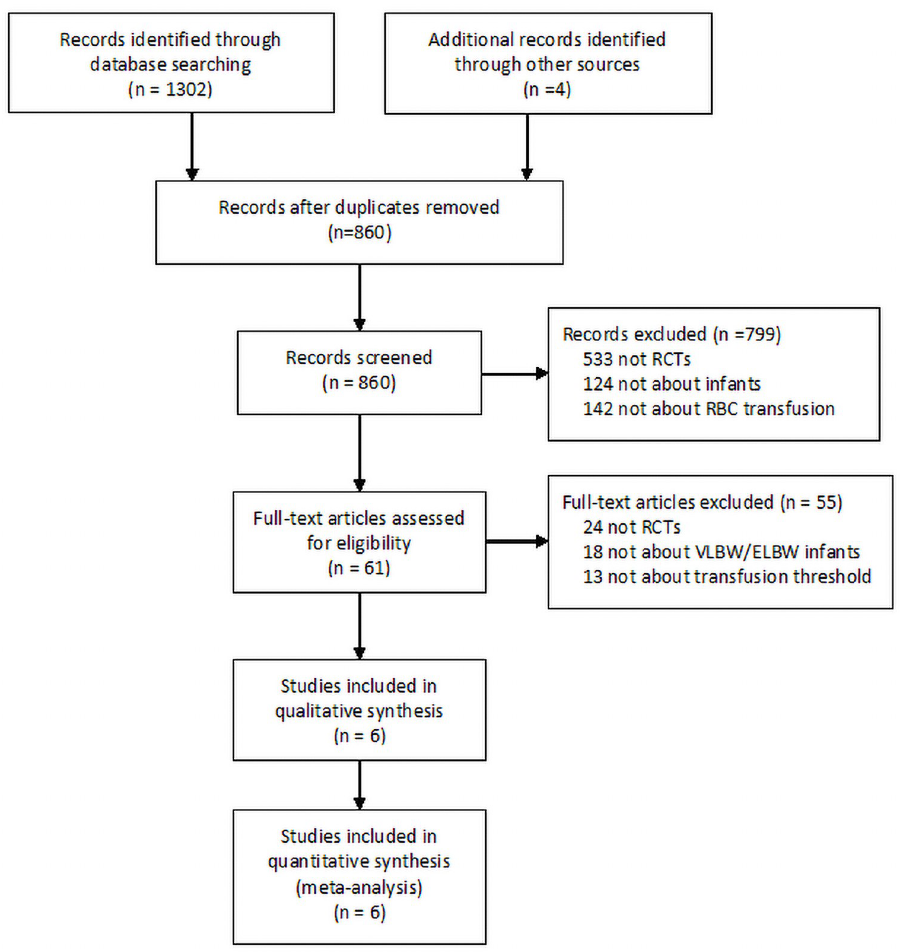
Fig 1. PRISMA flow chart of the studies recruited in this